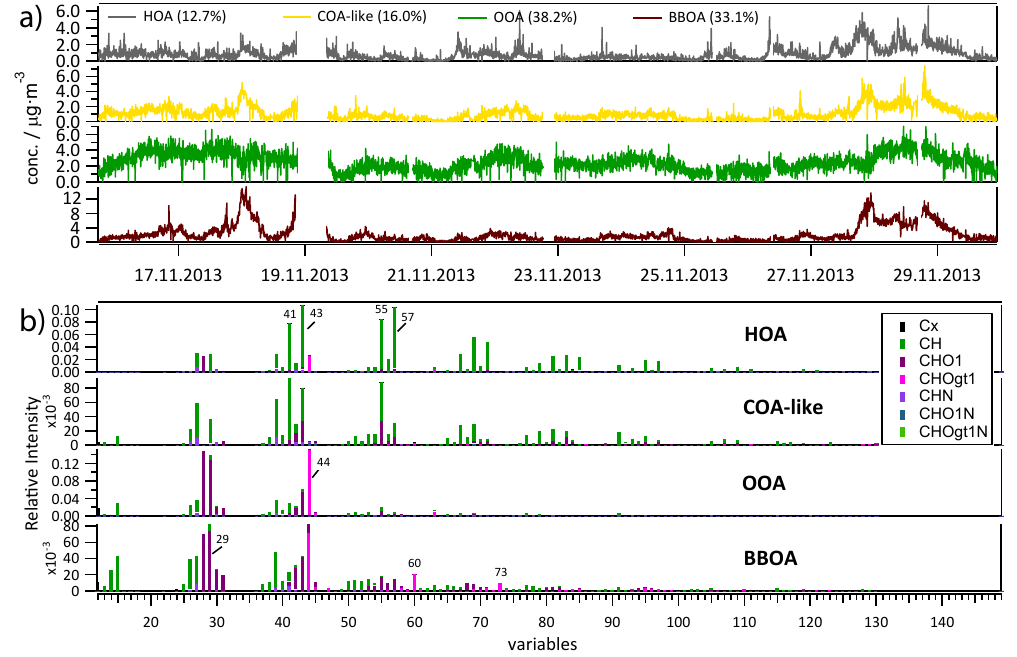
Figure 3. Factor time series in µgm − 3 (a) and relative factor profiles (b) of the HR PMF source apportionment. In both ( a and b ) the factors are ordered from top to down as follows: HOA (grey), COA-like (yellow), OOA (green), BBOA (brown). Average contributions of each factor are given in brackets in (a) . The profiles are shown on a UMR axis with different colours for the various species families (see legend in the plot, gt here means “greater